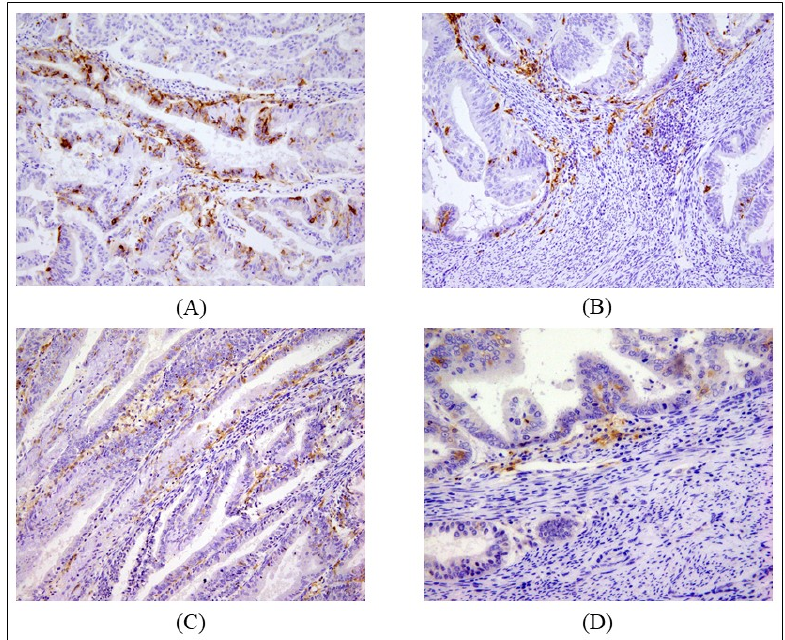
Figure 3. Examples of positively identified DCs infiltrating EC samples. A cell was considered as positively stained if at 40× magnification it had a visible nucleus, dendritic appearance, and intensely colored cytoplasm. ( A ) DC CD1a+ infiltrating stroma and glands of endometroid cancer at 20× magnification; ( B ) DC CD1a+ infiltrating border of endometroid cancer at 20× magnification; ( C ) DC CD1c+ infiltrating stroma and glands of endometroid cancer at 20× magnification; ( D ) DC CD1c+ infiltrating invasive border of endometroid cancer at 40× magnification (9 cells/HPF).